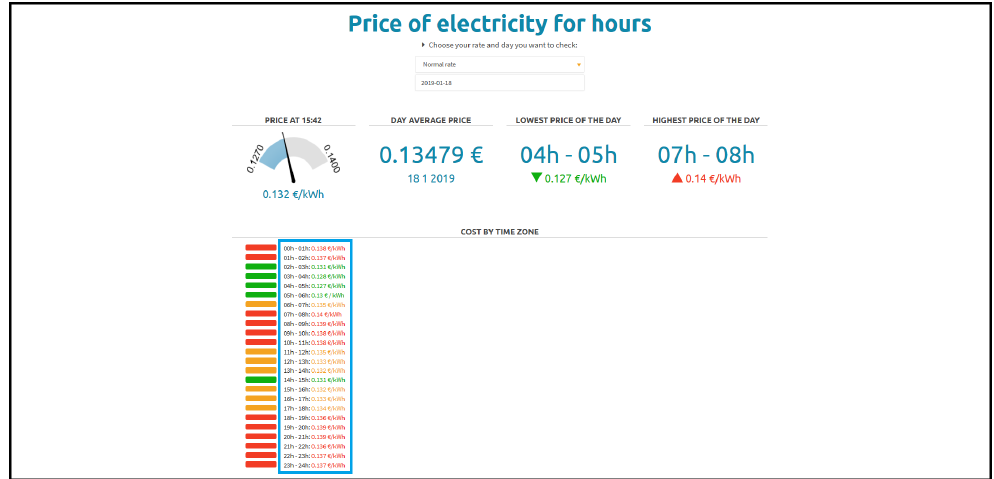
Figure 7. Web page used for the prices dataset.